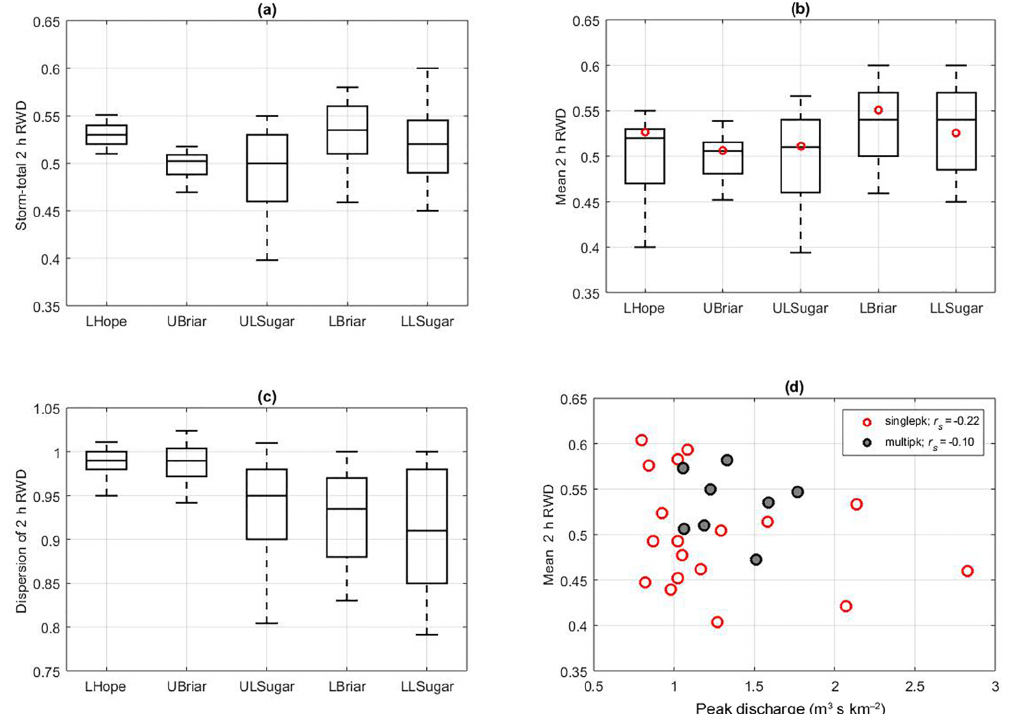
Figure 6. Box plots of RWD values for storm total rainfall (a) ; mean RWD for a 2h window (b) and RWD dispersion for a 2h window (c) , for all events, for the five basins; scatter plot of mean RWD versus peak flow (d) , for Lower LSugar, distinguishing between events with single and with multiple flow peaks. Red circles in box plots indicate RWD associated with spatially uniform rainfall. Table 3. Summary of correlations between both peak flow ( Q peak ) and lag time ( T lag ) and total basin-average rainfall ( R tot ), peak rainfall intensity ( R max ), normalized RWD associated with storm event total accumulated rainfall (RWD tot ), mean normalized RWD for a 2h time window (RWD m ) and gradient in RWD for a 2h time window (RWDgrad). Basin Peak flow Lag time Name vs. R